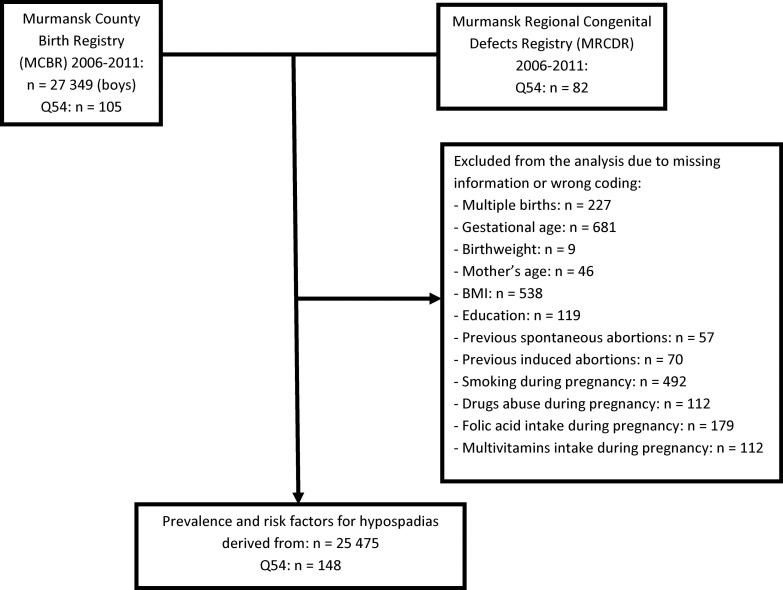
Number of births and exclusions for the combined Murmansk County Birth Registry and the Murmansk Regional Congenital Defects Registry (2006–2011).The individual numbers add up to more than the total number excluded due to missing information on two or more variables.